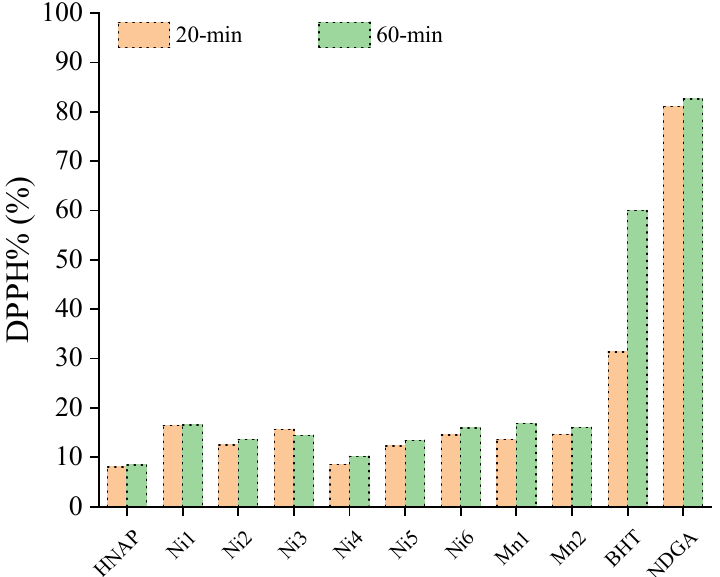
Figure 23. DPPH scavenging activity (DPPH%) of naproxen and its reported complexes after 20 min and 60 min incubation. (Codes of compounds: HNAP = naproxen; Ni1 = [Ni(NAP) 2 (CH 3 OH) 4 ]; Ni2 = [Ni(NAP) 2 (bipy)(CH 3 OH)]; Ni3 = [Ni(NAP) 2 (phen)(Η 2 Ο)]; Ni4 = [Ni(NAP) 2 (bipyam)]; Ni5 = [Ni(NAP) 2 (Hpko) 2 ]; Ni6 = [Ni(NAP) 2 (py) 2 (Η 2 Ο) 2 ]; Mn1 = [Mn(NAP) 2 (py) 2 (H 2 O) 2 ] and Mn2 = [Mn(NAP) 2 (phen)(H 2 O)].)